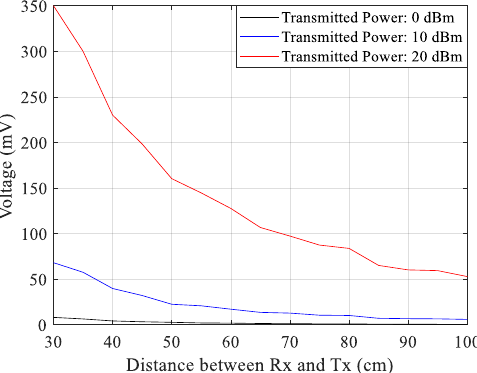
Figure 16. WPT system DC output power for different distances and distinct transmitted powers.